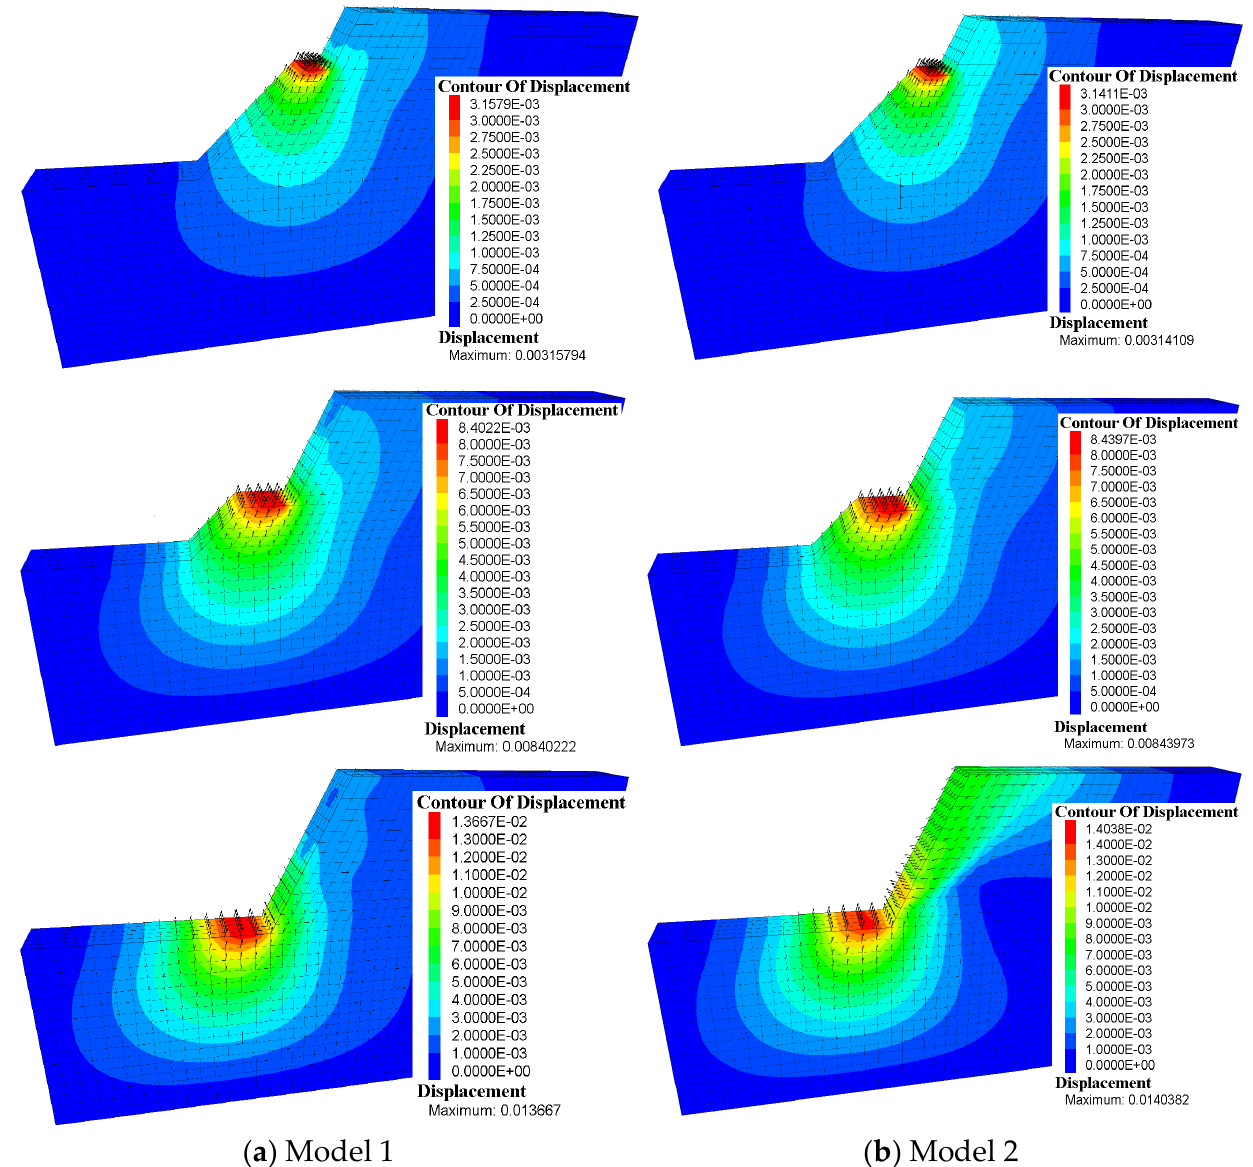
Figure 10. Comparison of the total displacements under different stages (unit: m). The comparative displacement analysis for model 1 and model 2 shows that the pre-set anchor has little effect on the amounts and the directions of the maximum total displacement beneath each excavation level but has a significant influence on the amounts and the directions of the total displacement behind the design slope surface exposed by multi-excavation. The difference in total displacement characteristics between the two models, especially after the last excavation, can be explained in that the pre-set anchors in model 1 indirectly change the characteristics of vertical displacement or even total displacement by directly restricting the horizontal displacement of the cutting slope above each excavation level due to the near-horizontal setting of the anchors (see Figure 11). Figure 11 shows that the maximum horizontal displacement of the cutting slope surface of model 1 is only about 38.6% of the maximum horizontal displacement of the cutting slope surface of model 2 after the third